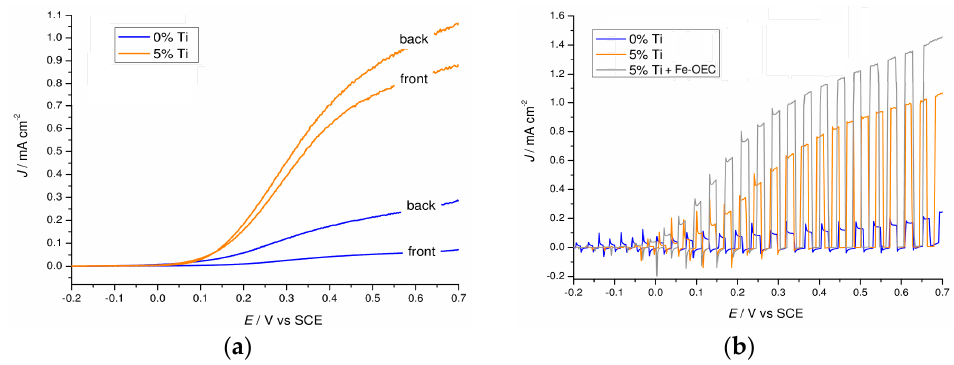
Figure 8. J–V curves of modified hematite photoanodes. ( a ) J–V comparison between back (FTO side) and front (electrolyte side) illumination for unmodified (blue lines) and 5% Ti-modified (orange lines) hematite electrodes; ( b ) J–V curves of unmodified (blue line) and 5% Ti-modified hematite electrode before (orange line) and after (grey line) functionalization with Fe-OEC recorded under shuttered AM 1.5G illumination.